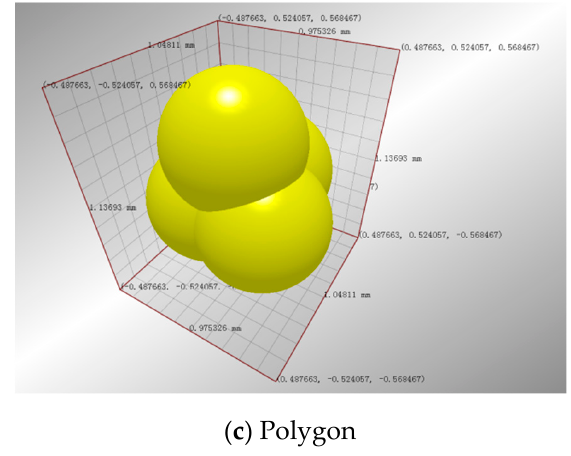
Figure 6. Three typical particle models 0.63–1.25 mm in size in quartz sand 3.